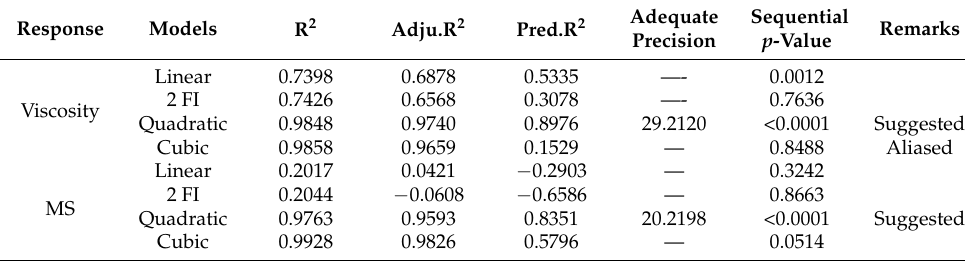
Table 4. Model statistical